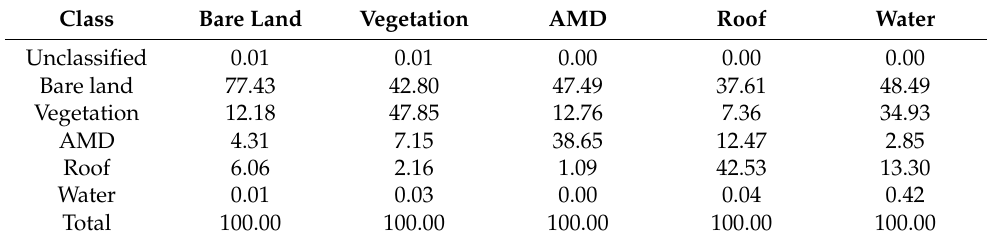
Note: Overall Accuracy = 30.35%. Table 4. The confusion matrix of the RF results (%).